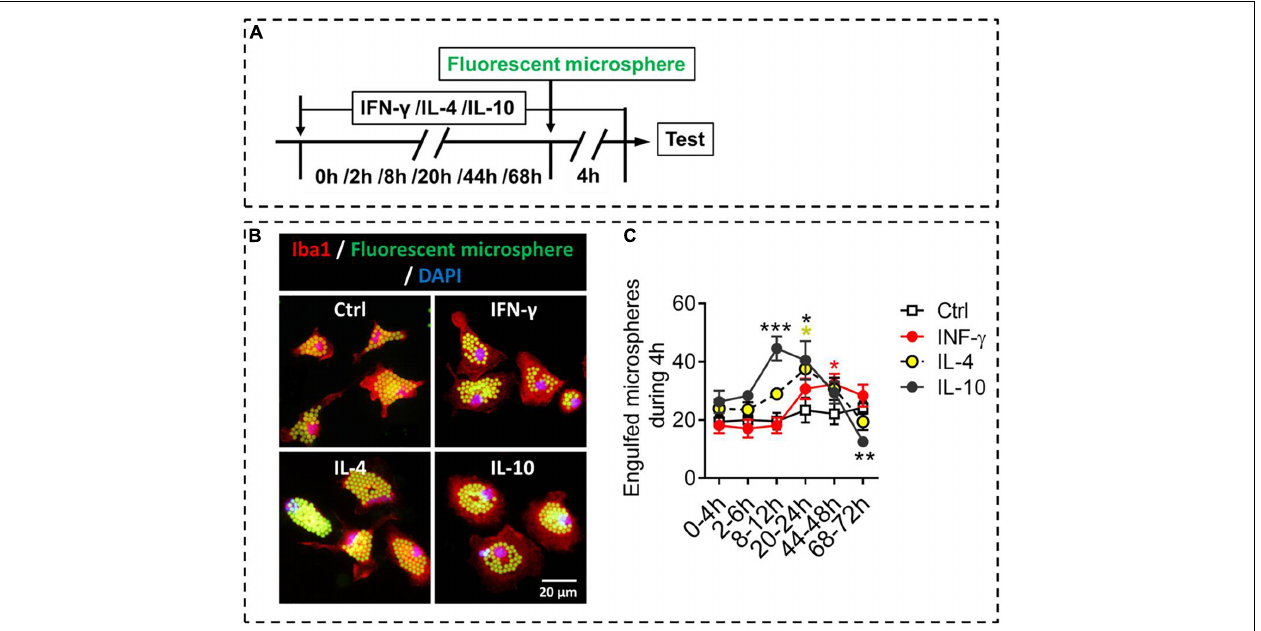
FIGURE 6 | Phagocytic ability of microglial phenotypes induced by IFN- γ , IL-4, or IL-10. (A) Experimental scheme to monitor phagocytic ability during activation. Microglia underwent stimulation with IFN- γ , IL-4, or IL-10 for 0–68 h, then fluorescent microspheres were added and incubated with microglia for 4 h. (B) Representative micrographs showing immunocytochemical labeling for Iba1 (red) and engulfed fluorescent microspheres in microglia treated with IFN- γ , IL-4, or IL-10. (C) Quantification of the number of engulfed fluorescent microspheres in microglia during 4 h after treatment with IFN- γ , IL-4, or IL-10 for 2–72 h. Five, 40 × micrographs were taken from each well, and all cells in the field were measured. Data are presented as mean ± SEM ( n = 5–6 well per group), * P < 0.05, *** P < 0.005 (one-way ANOVA with Tukey’s multiple-comparisons